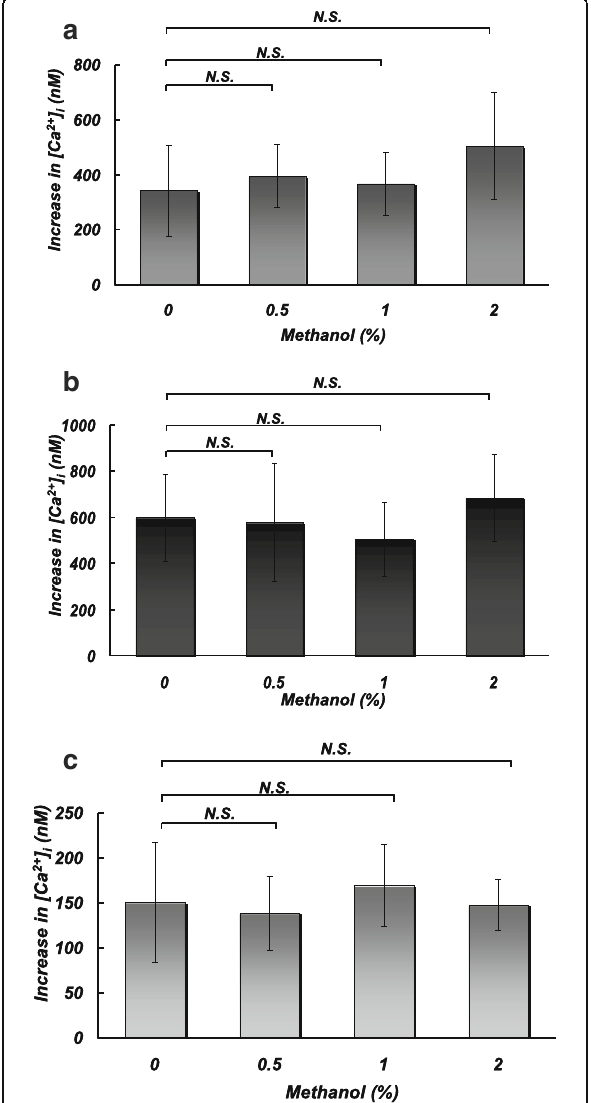
Fig. 2 Effects of pretreatment with different concentrations (0, 0.5, 1, and 2%) of methanol on platelet aggregation (at 5 min) induced by extracellular addition of CaCl 2 (0.5 mM) in the presence of thrombin (0.025 U/ml) ( a ), thapsigargin (1 μ M) ( b ), or OAG (100 μ M) ( c ). Asterisks denote significant differences (** p <0.01) compared with the control. N.S. no significant difference. N =5